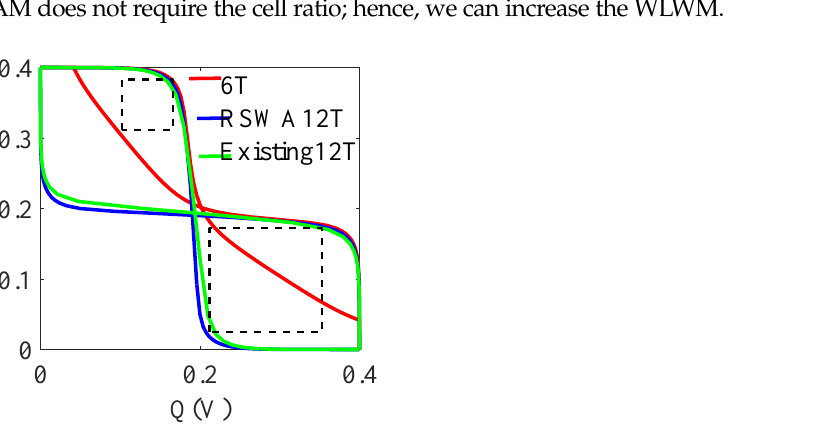
Figure 5. Comparison of RNM with conventional 6T and state-of-the-art 12T SRAM cell.